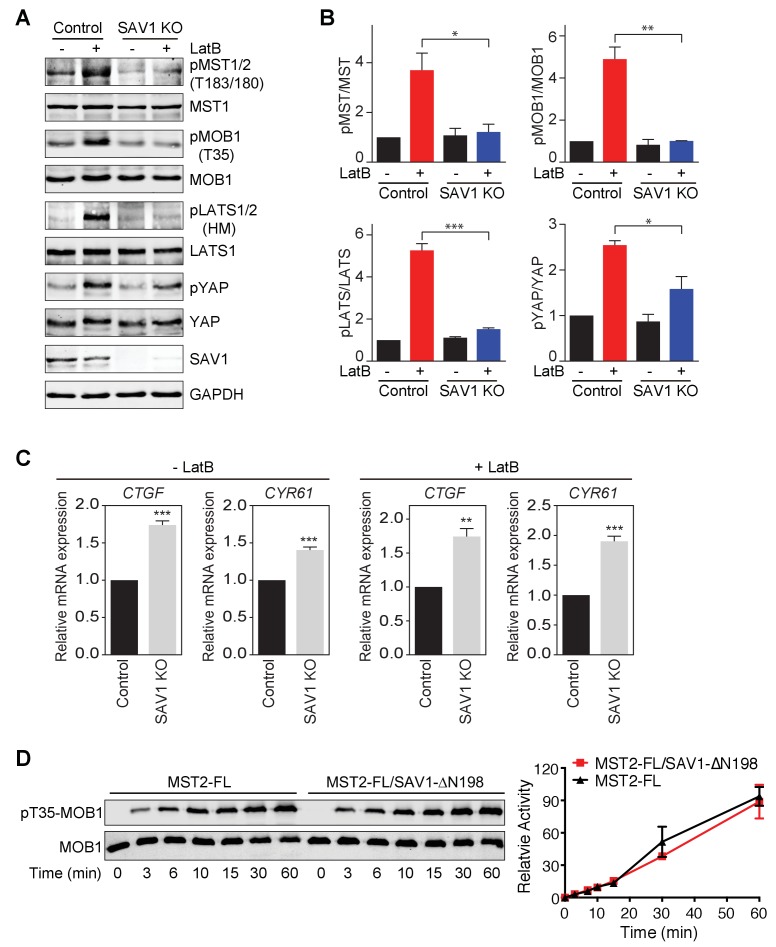
SAV1 is required for Hippo pathway activation in human cells.(A) Immunoblots of cell lysates of MCF10A and MCF10A-SAV1 KO cells with or without latrunculin B (LatB) treatment with the indicated antibodies. Both control and SAV1 KO cells were treated with LatB (1 μg/ml) or vehicle for 1 hr before they were harvested. (B) Quantification of the ratios of pMST/MST, pMOB1/MOB1, pLATS/LATS, and pYAP/YAP signals in (A). The total and phosphorylated protein levels were individually normalized to GAPDH levels. Normalized values were used to calculate the ratios. Data are plotted as mean ± SEM of three biological replicates (*p<0.05; **p<0.01; ***p<0.001). (C) Relative expression of YAP target genes CTGF and CYR61 in control and SAV1 KO MCF10A cells with or without LatB treatment. Data are plotted as mean ± SEM of three biological replicates (**p<0.01 and ***p<0.001). (D) Quantitative immunoblots with the indicated antibodies of the in vitro kinase reactions containing human MOB1 and the indicated MST2-FL or MST2-FL/SAV1-∆N198 proteins at the indicated times. The relative pT35-MOB1 signal intensities, normalized to those of MST2 FL and MST2-FL/SAV1-∆N198 at 60 min (100%), respectively, are plotted against time. Means ± range for two biological replicates are plotted.